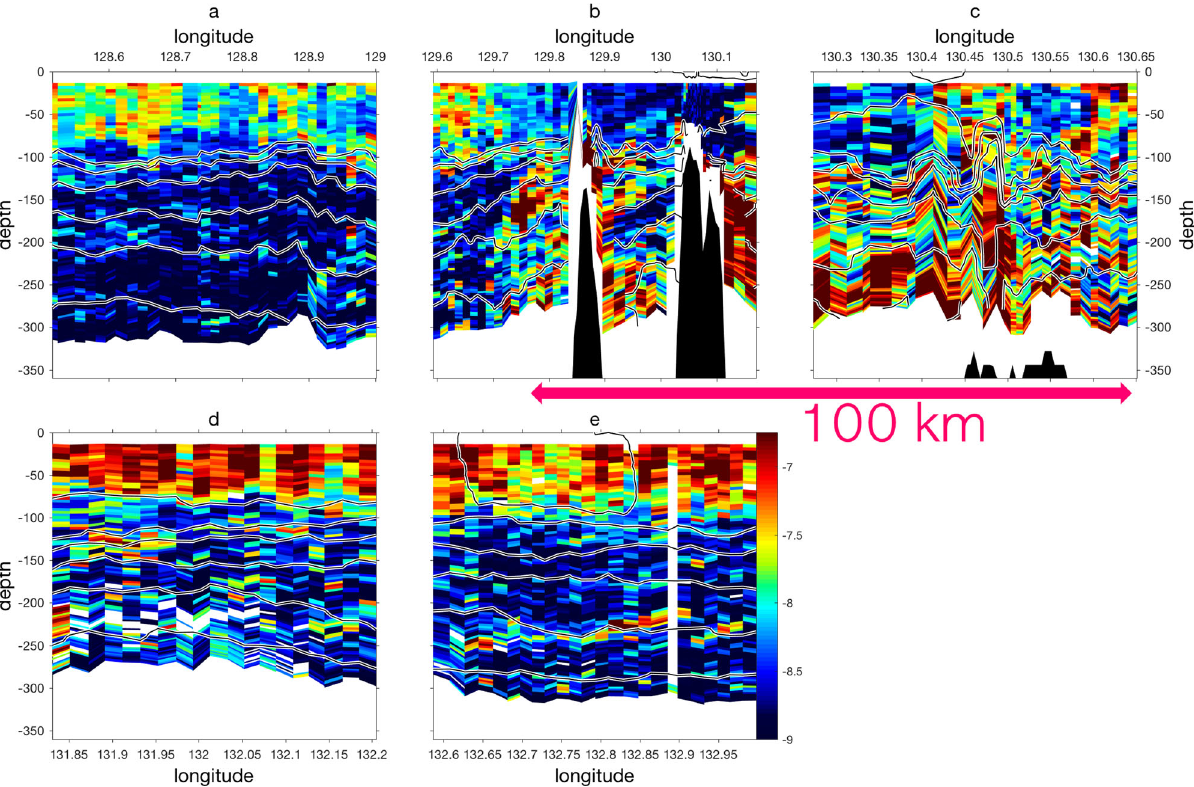
Fig. 2 Measured turbulent kinetic energy dissipation rates. Turbulent kinetic energy dissipation rates ε (log 10 W kg – 1 ) for ( a ) Leg a, ( b ) Leg b, ( c ) Leg c, ( d ) Leg d, and ( e ) Leg e. Contours represent isopycnals as in Fig. 1. Seamount topography in the Tokara Strait is shown as black in ( b , c